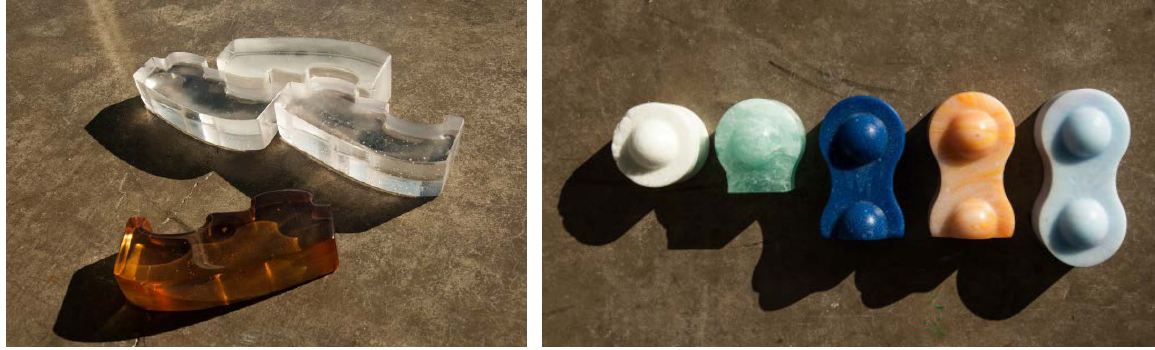
Fig:7: Type D blocks: Wall configuration Fig.8: Type E blocks out of recycled, coloured